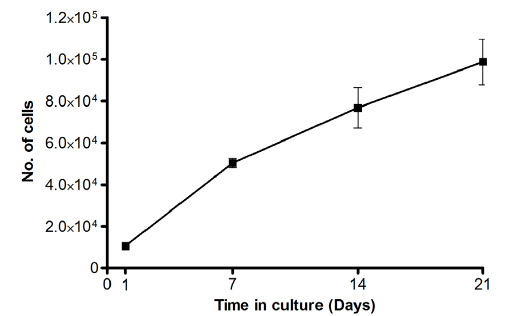
Figure 3. Proliferation of osteoblast-like cells grown on PLDLA scaffolds for 21 days. The points represent the mean ± SD of five independent experiments.